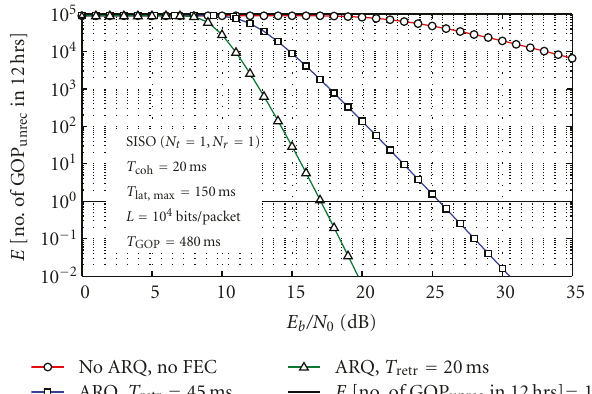
Figure 12: Average number of GOPs a ff ected by unrecoverable packet loss in 12 hours (SISO,